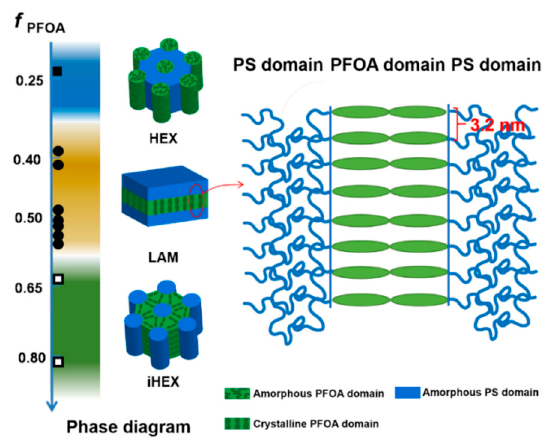
Figure 5. Phase diagram and illustration of hierarchical structure of S- b -F block copolymers. Solid square, solid sphere, and hollow square represent experiment data for hexagonally packed cylinders (HEX), lamellar layers (LAM), and inverse hexagonally packed cylinders (iHEX) phases.